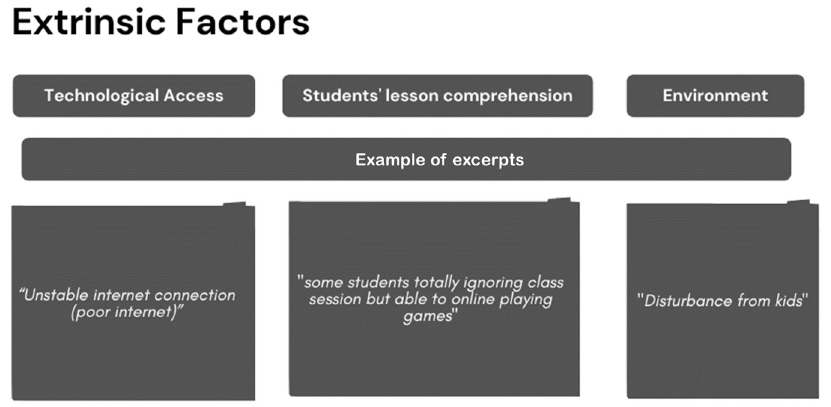
Figure 3. Extrinsic Factors.